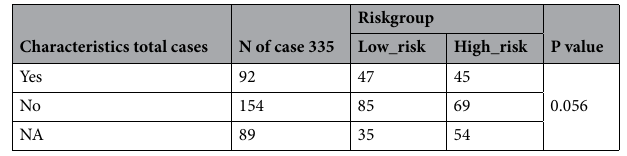
Table 4. Clinical features of the